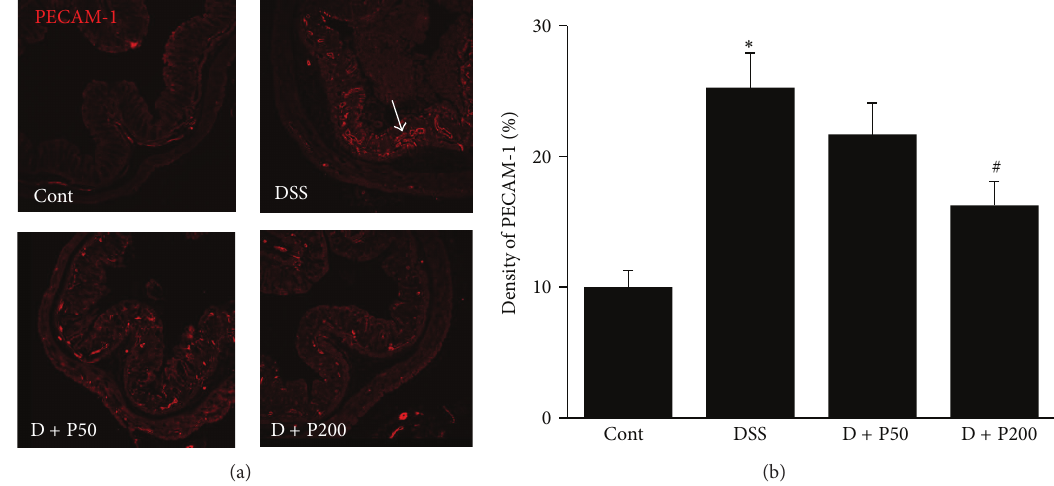
Figure 3: Angiogenesis in a 𝛾 -PGA-treated DSS-induced colitis model. (a) Colonic microvasculature stained for endothelial cells (200x magnification) using the CD31 antibody. Control group (without DSS; Cont), 3% DSS administration group (DSS), 3% DSS with 𝛾 -PGA at 50 mg/kg body weight per day (D + P50), 3% DSS with 𝛾 -PGA at 200 mg/kg body weight per day (D + P200). (b) Analysis of the area densities of blood vessels. Bars represent the mean ± SD from 3 slides per mouse. ∗ 𝑃 < 0.05 , DSS versus Cont; # 𝑃 < 0.05 , D + P50 and D + P200 versus